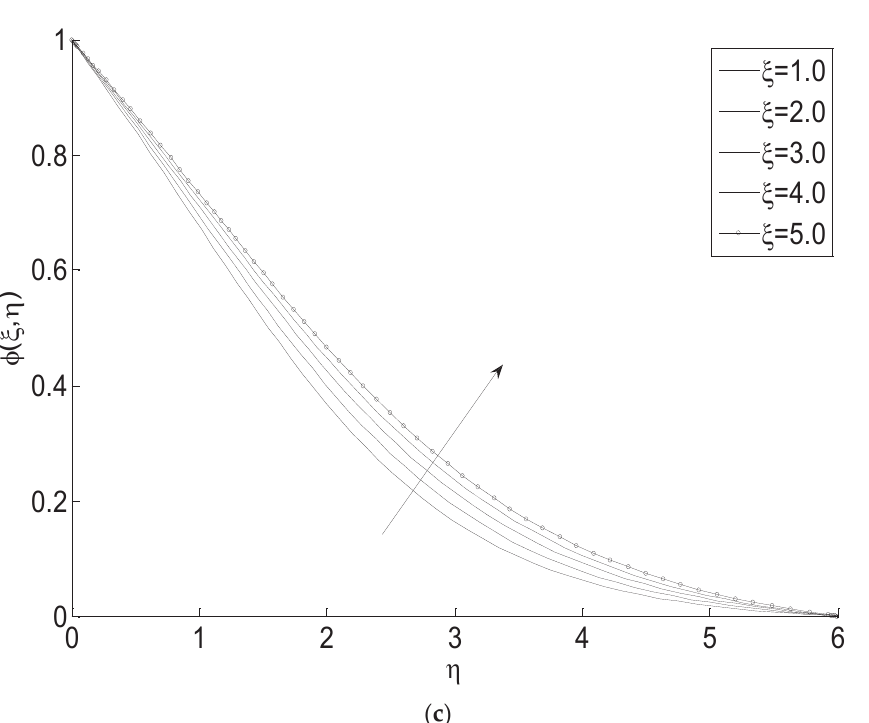
Figure 6. ( a – c ) Velocity, temperature, and concentration profiles, respectively, with different position parameters at n = 1.0, Sc = 1.0, N = 1.0, γ = 2.01, ε = 0.45, f w = 0.0, κ = 0.5, and Nt = 1.0.